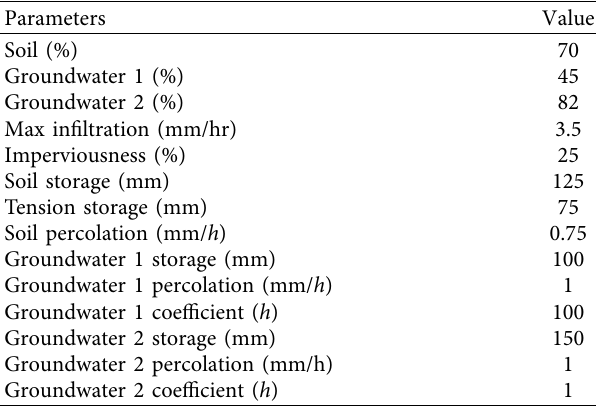
Table 1: Calibrated parameters in the SMA